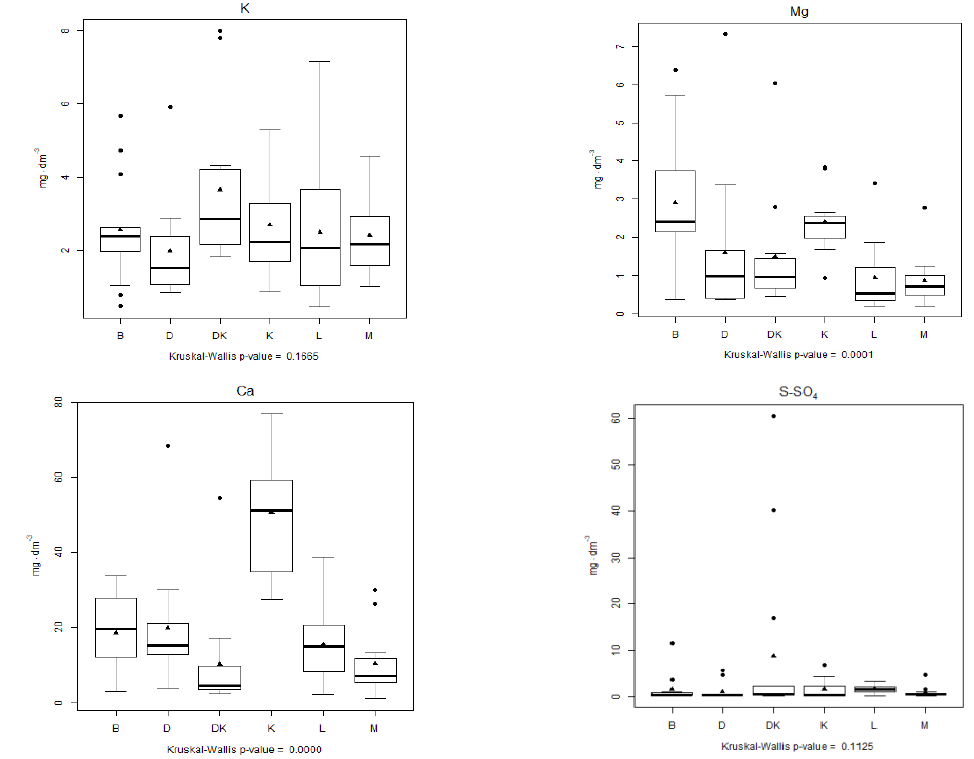
Figure 6. Distribution of the values of the investigated physical–chemical parameters of piezometric groundwater at six study sites in the period 2011–2014. The x axis label provides the p -value derived by the Kruskal–Wallis test. The horizontal line across the central region of the box represents the median. The mean value of the data is marked by a filled triangle. Any observation not included between the whiskers is considered an outlier and is represented by a filled circle.